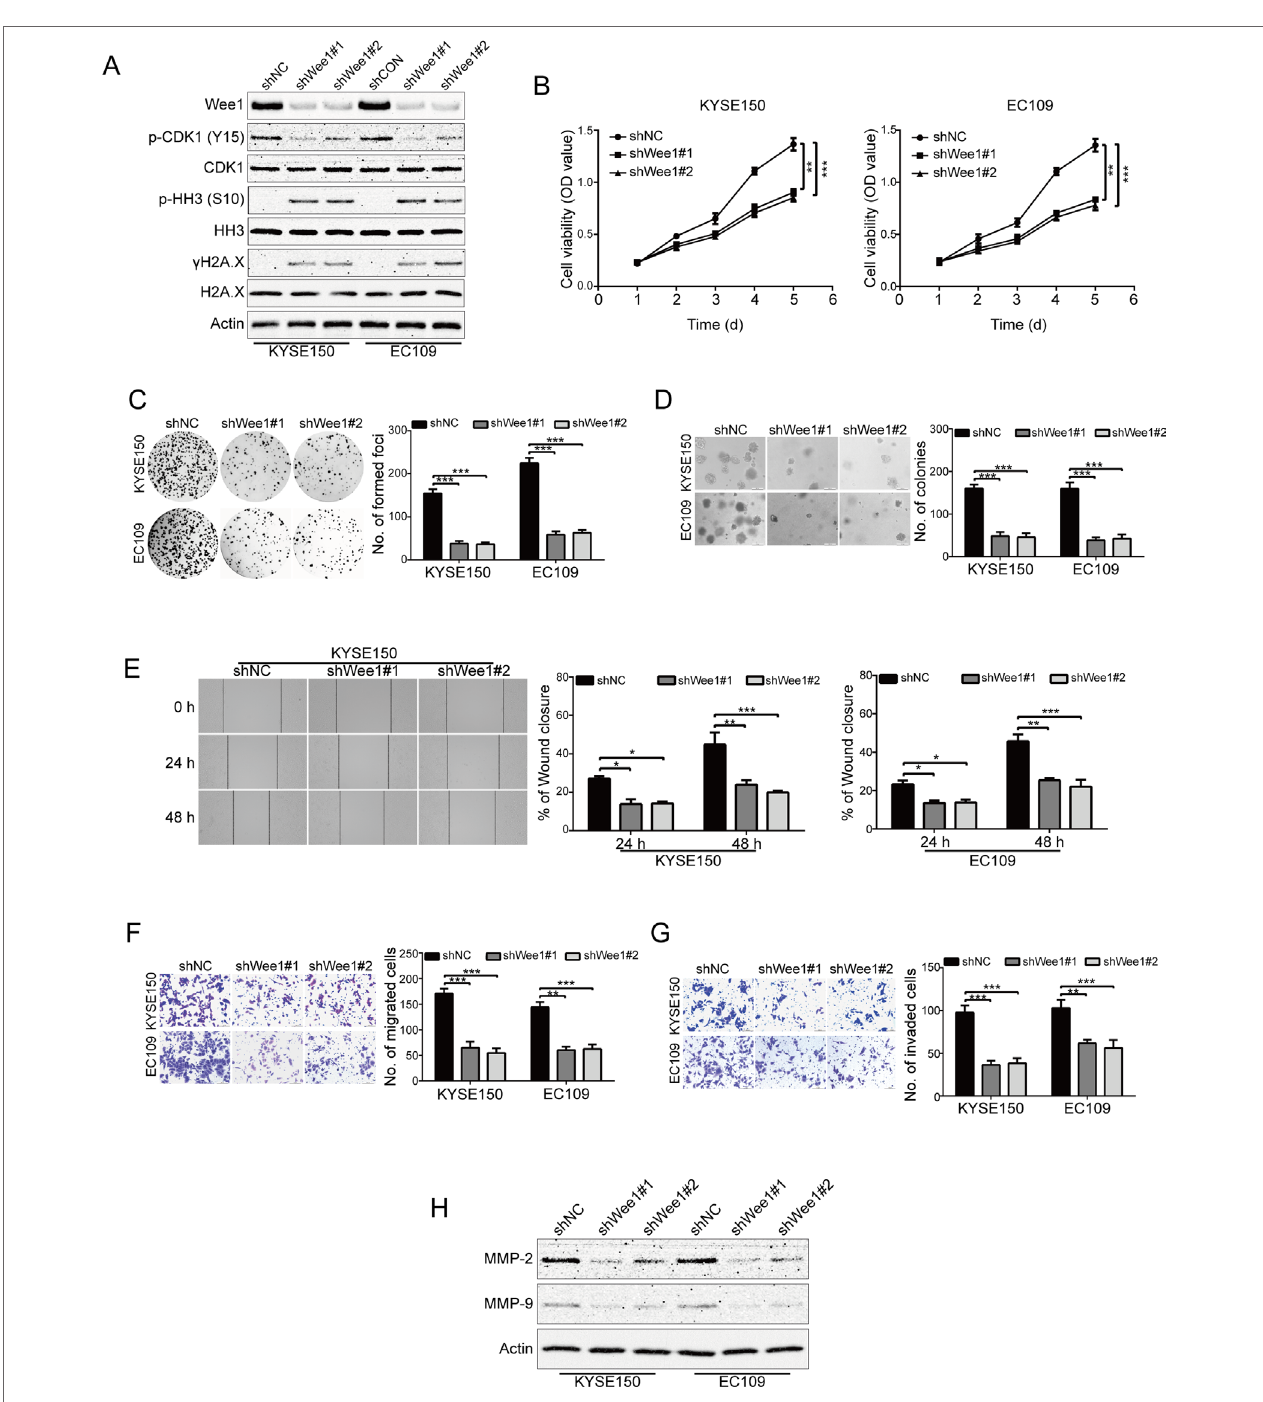
FIGURE 5 | Knockdown of Wee1 inhibits proliferation, migration and invasion of ESCC cells. (A) Western blotting analysis of the indicated proteins in KYSE150 and EC109 cells stably transfected with the indicated shRNA. (B–D) MTT (B) , focus colony formation (C) , and soft agar clonogenic (D) assays were performed to detect the cell growth of ESCC cells that stably knocked down for Wee1 by shRNA ( n = 6 per group). shNC: control shRNA; shWee1#1 and shWee1#2: two different shRNAs targeting Wee1. (E–G) Wound healing (E) , transwell migration (F) , and invasion (G) assays of KYSE150 and EC109 cell stable clones with knockdown of Wee1 ( n = 6 per group). Scale bar: 100 μm. (H) Western blotting analysis of MMP-2 and MMP-9 expression in Wee1-knockdown ESCC cells by shRNA. Actin served as a loading control. * P < 0.05, ** P < 0.01, *** P < 0.001, versus shNC; P values were obtained by one-way ANOVA with post hoc intergroup comparison with Tukey’s